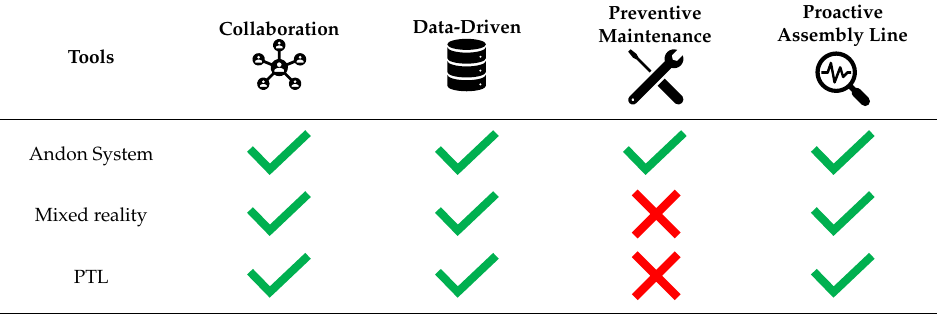
Table 8. The Smart Assembly Line — expectations fulfilled. PTL: pick-to-light.